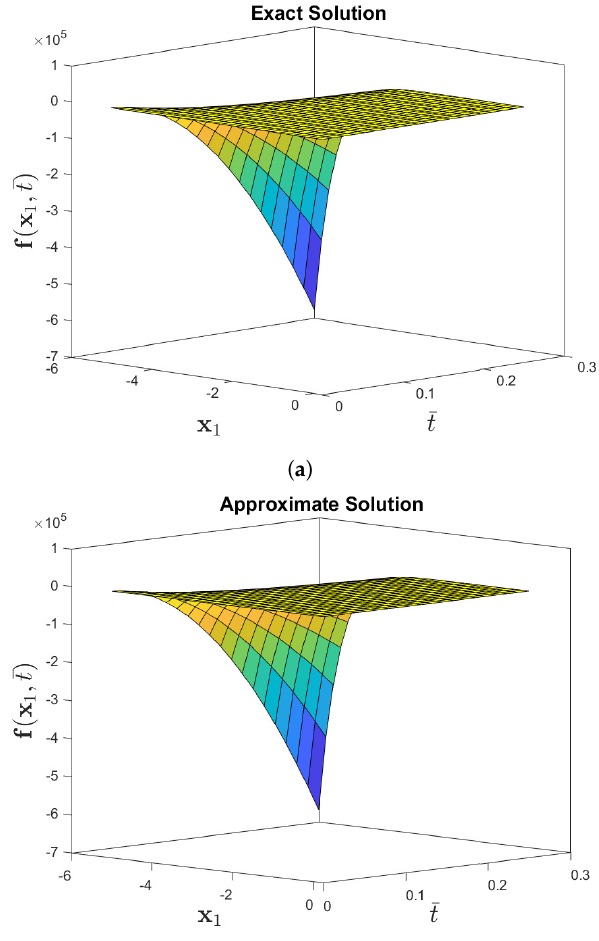
Figure 7. Numerical-behavior of exact and approximate solution to the f ( x 1 , ¯ t ) for Problem 3 when the parameters are θ = 1, β = 6, and ϕ = 0.